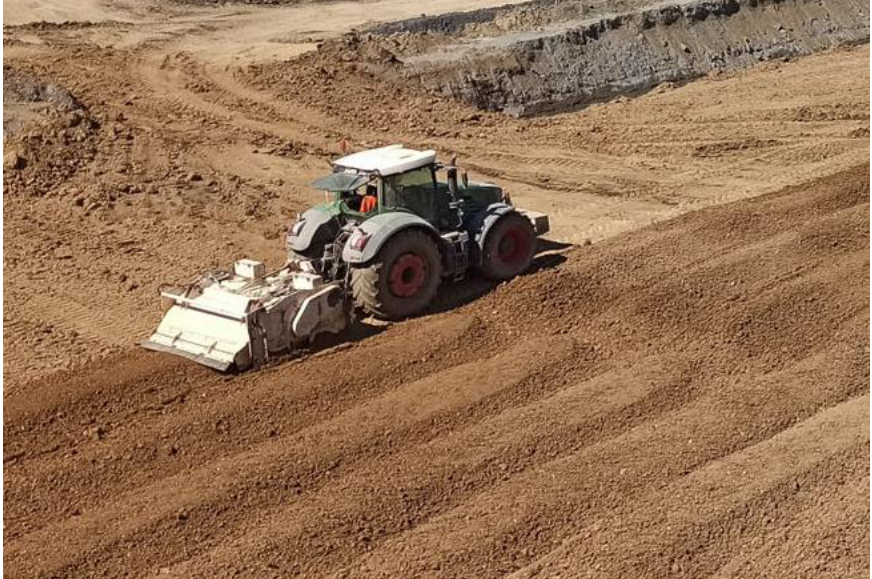
Figure 3. Mechanical drainage. A combination of stabiliser and tractor (photo: Michal Bernacki).